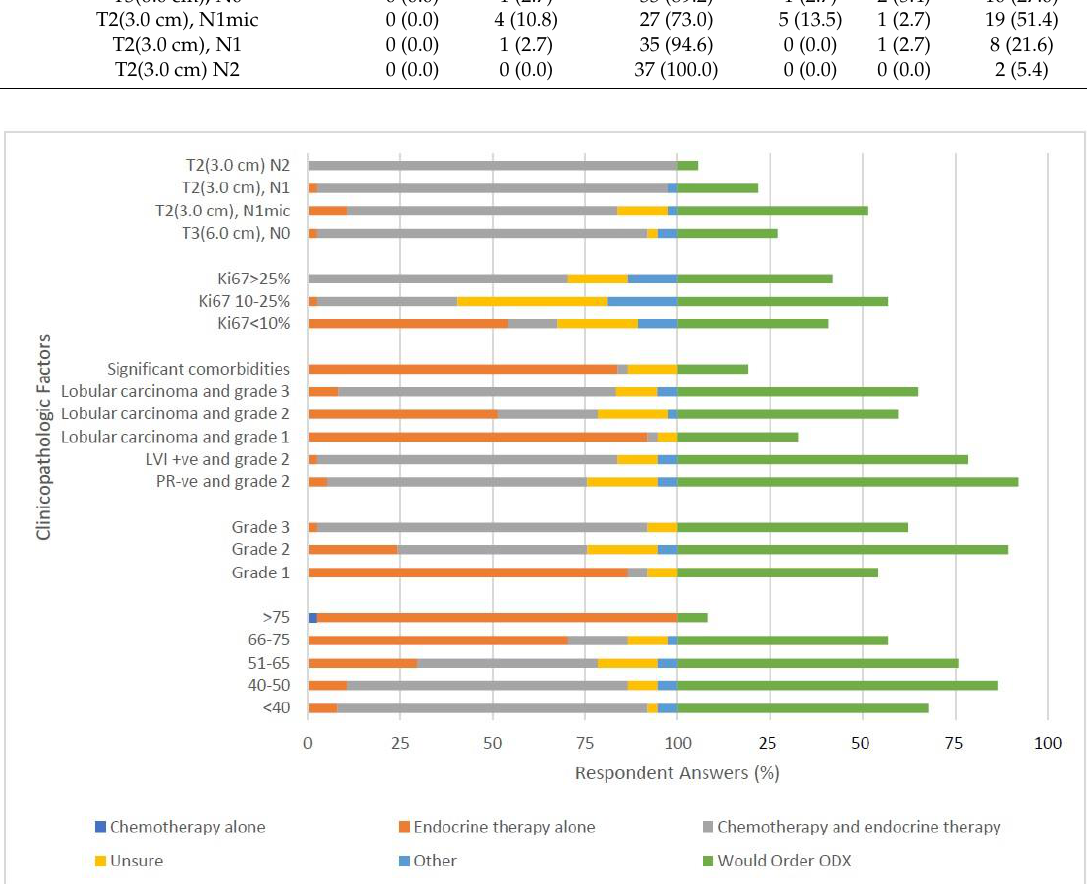
Figure 3. Treatment decisions made by the respondents for different theoretical patient cases. Included is data related to whether the respondent would order ODX for the theoretical patient cases as well.